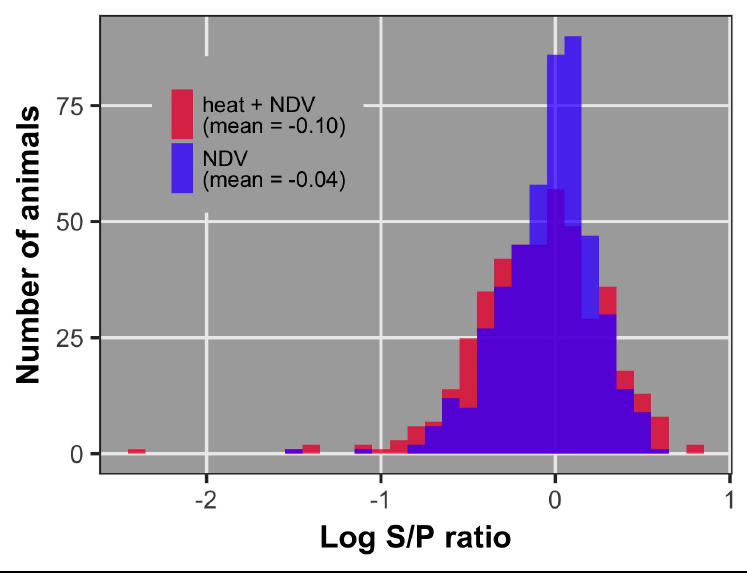
Figure 3. Antibody 10 dpi distribution by treatment group.